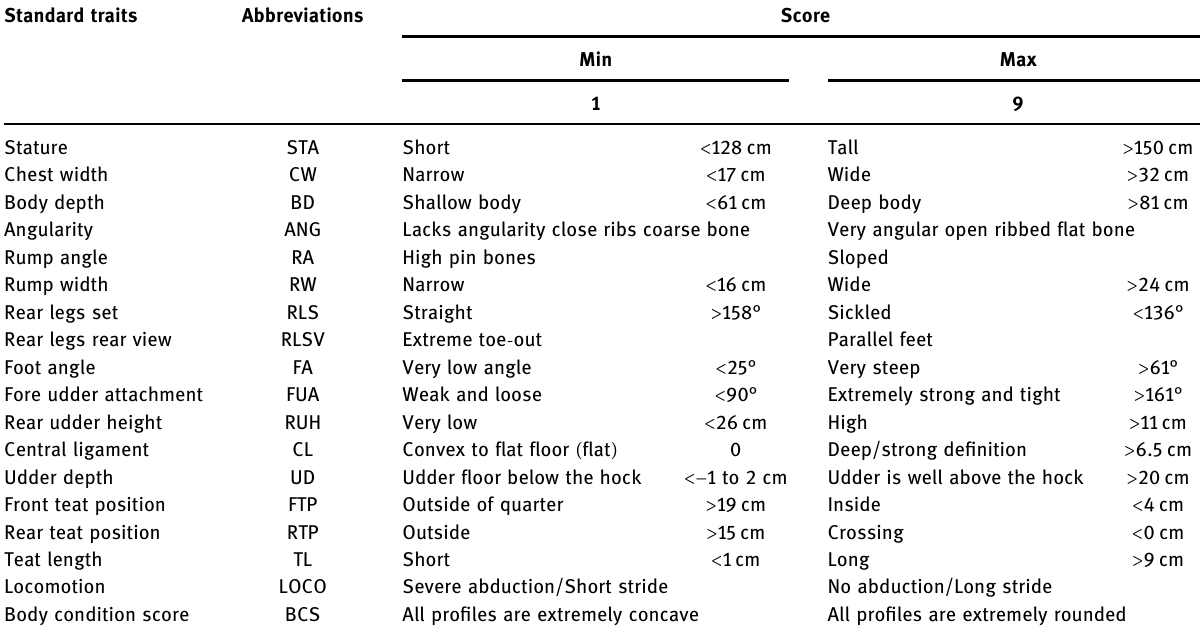
Table 1: Description of the linear - type traits using 9 - score system Standard